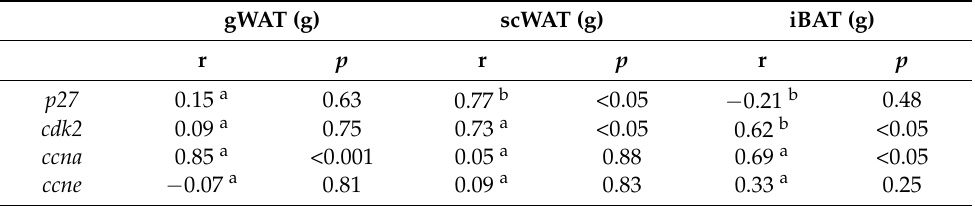
Table 1. Correlation analyses between the weight of gWAT, scWAT or iBAT from Aged CT and Aged DIO female mice, and the mRNA expression of p27 , cdk2 , ccna or ccne in each depot. gWAT (g)